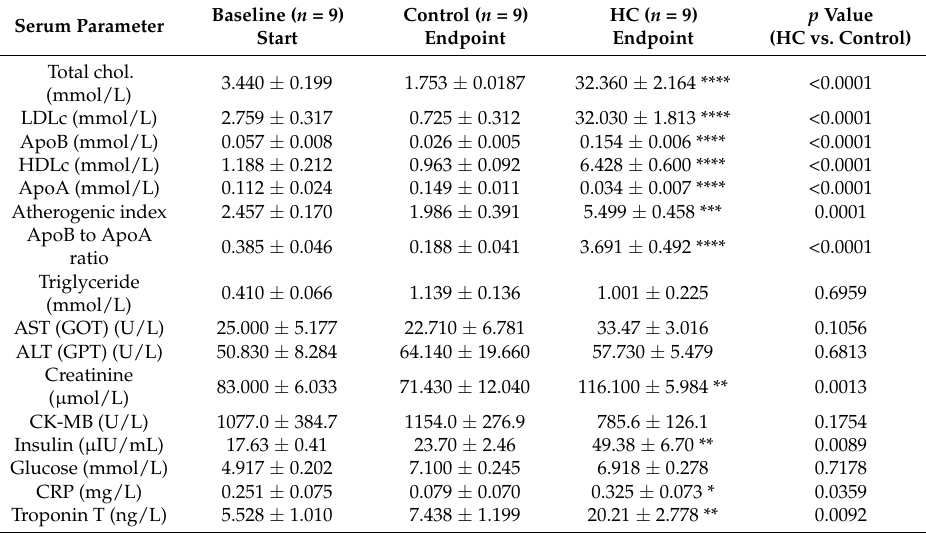
Table 4. Serum parameters. Serum lipid parameters increased dramatically in the HC group, as well as atherogenic index and ApoB/ApoA ratio. Troponin T levels were elevated, but did not reach the level referring to acute myocardial infarction. Student’s t -test was used to estimate differences between endpoint groups. Asterisks denote the level of statistical significance compared to Control (* p < 0.05; ** p < 0.01; *** p < 0.001; **** p < 0.0001). Total chol.: total cholesterol, LDLc: low-density